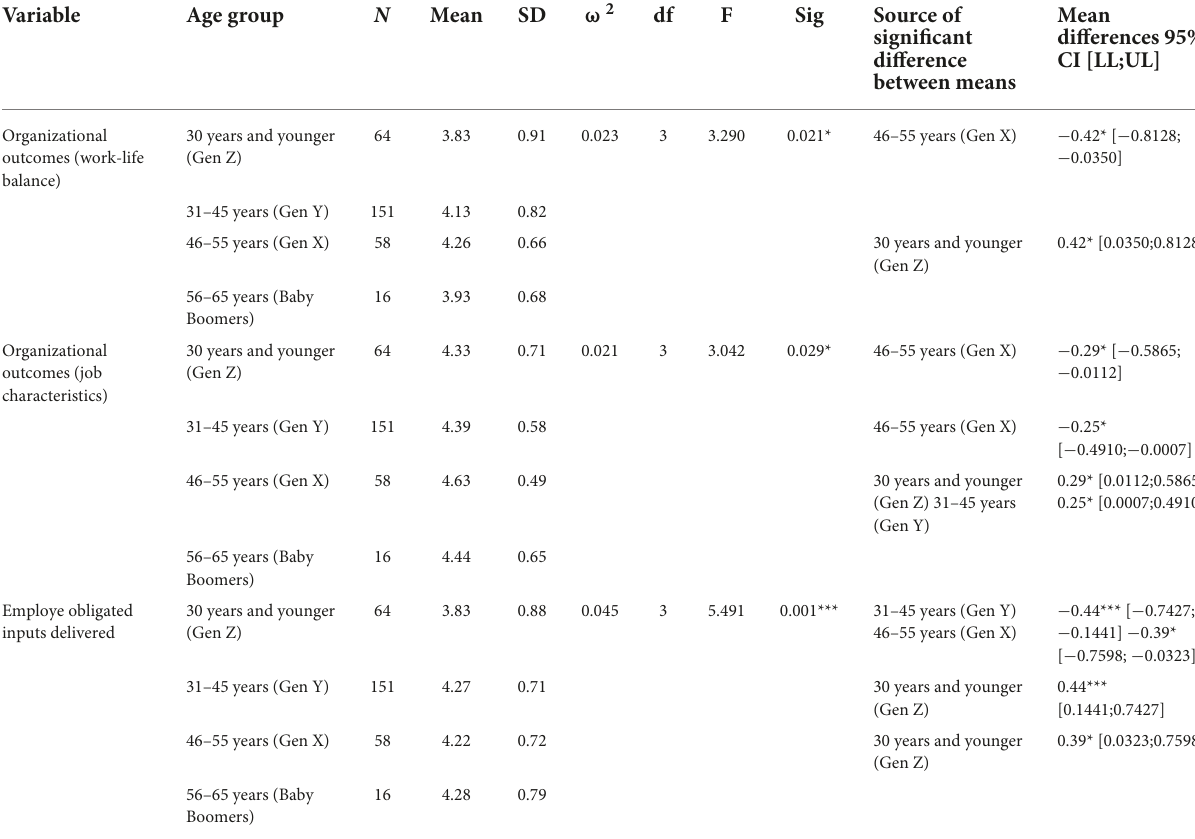
TABLE 1 ANOVA (with Post Hoc Bonferonni Tests): Organizational obligated outcomes, employe inputs delivered and generational groups. Variable Age